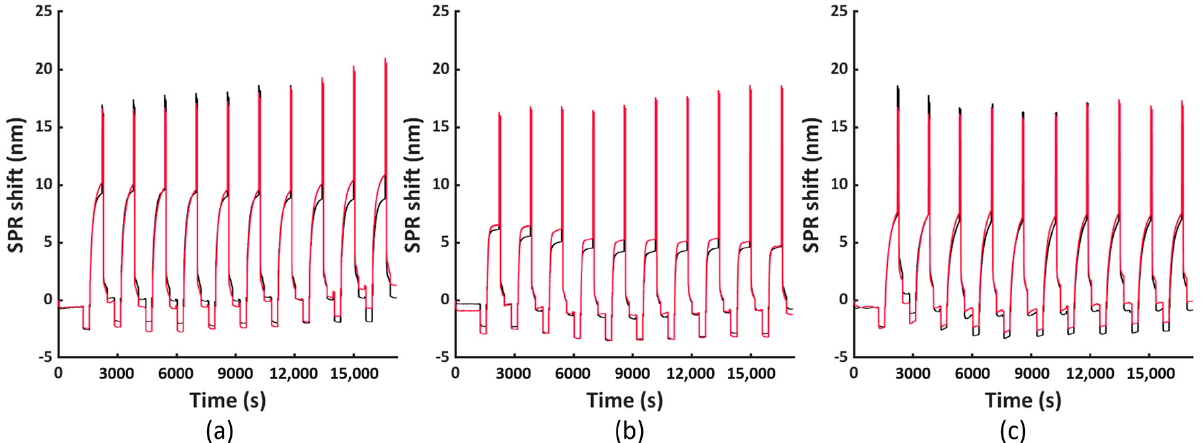
Figure 7. The FO − SPR sensorgrams obtained from two parallel FO probes representing ten regeneration cycles, performed using the optimized regeneration protocol (i.e., condition G combined with 3 min washing in 0.5 M NaOH), shown for different His 6 -tagged bioreceptor model systems: ( a ) RBD, ( b ) RFP and ( c ) Tet12SN − RRRR.